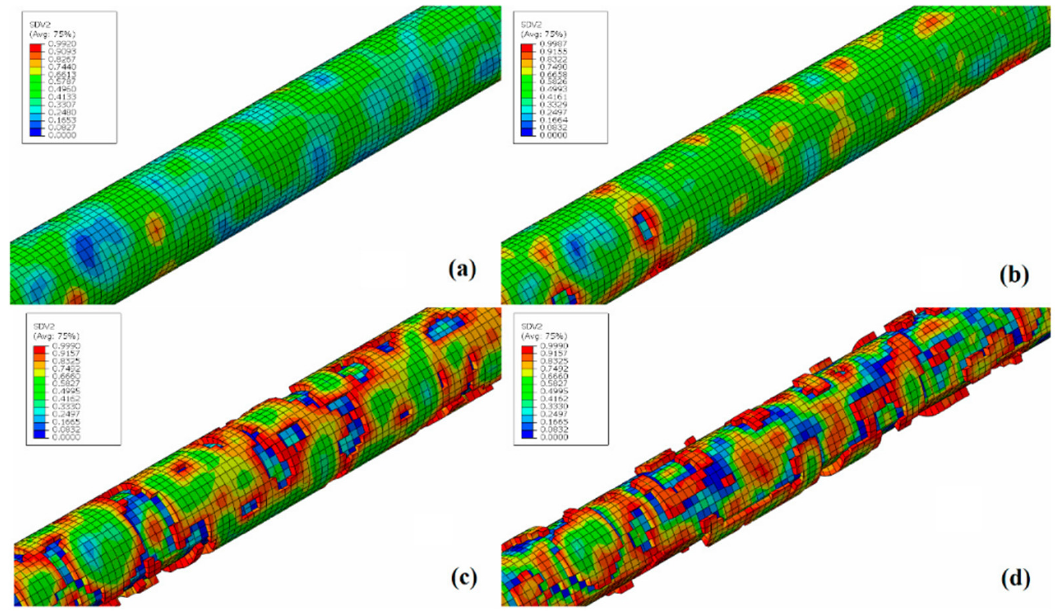
Figure 13. CP geometry during localized corrosion simulations for different immersion times. ( a ) = 24 h, ( b ) 48 h, ( c ) 96 h and ( d ) 168 h.